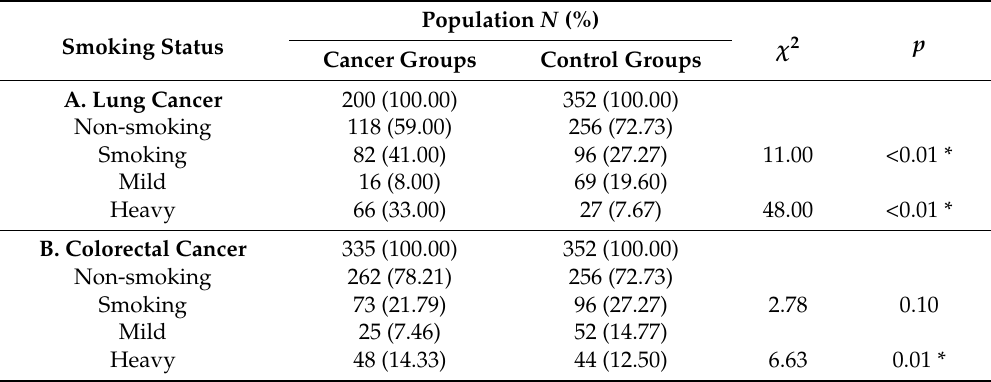
Table 3. Smoker distribution in tested